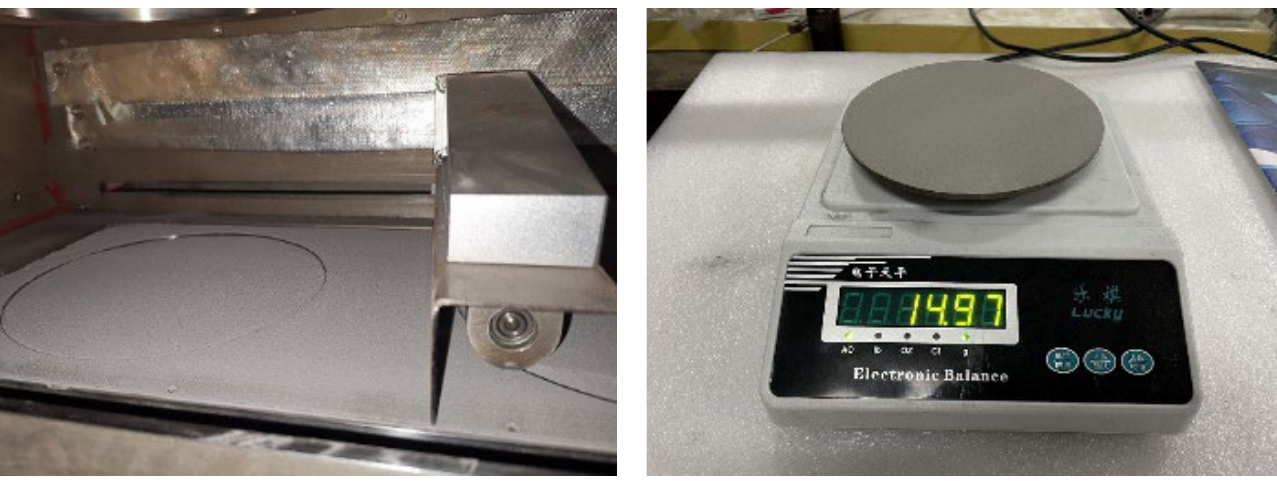
Figure 11. Actual powder laying effect.